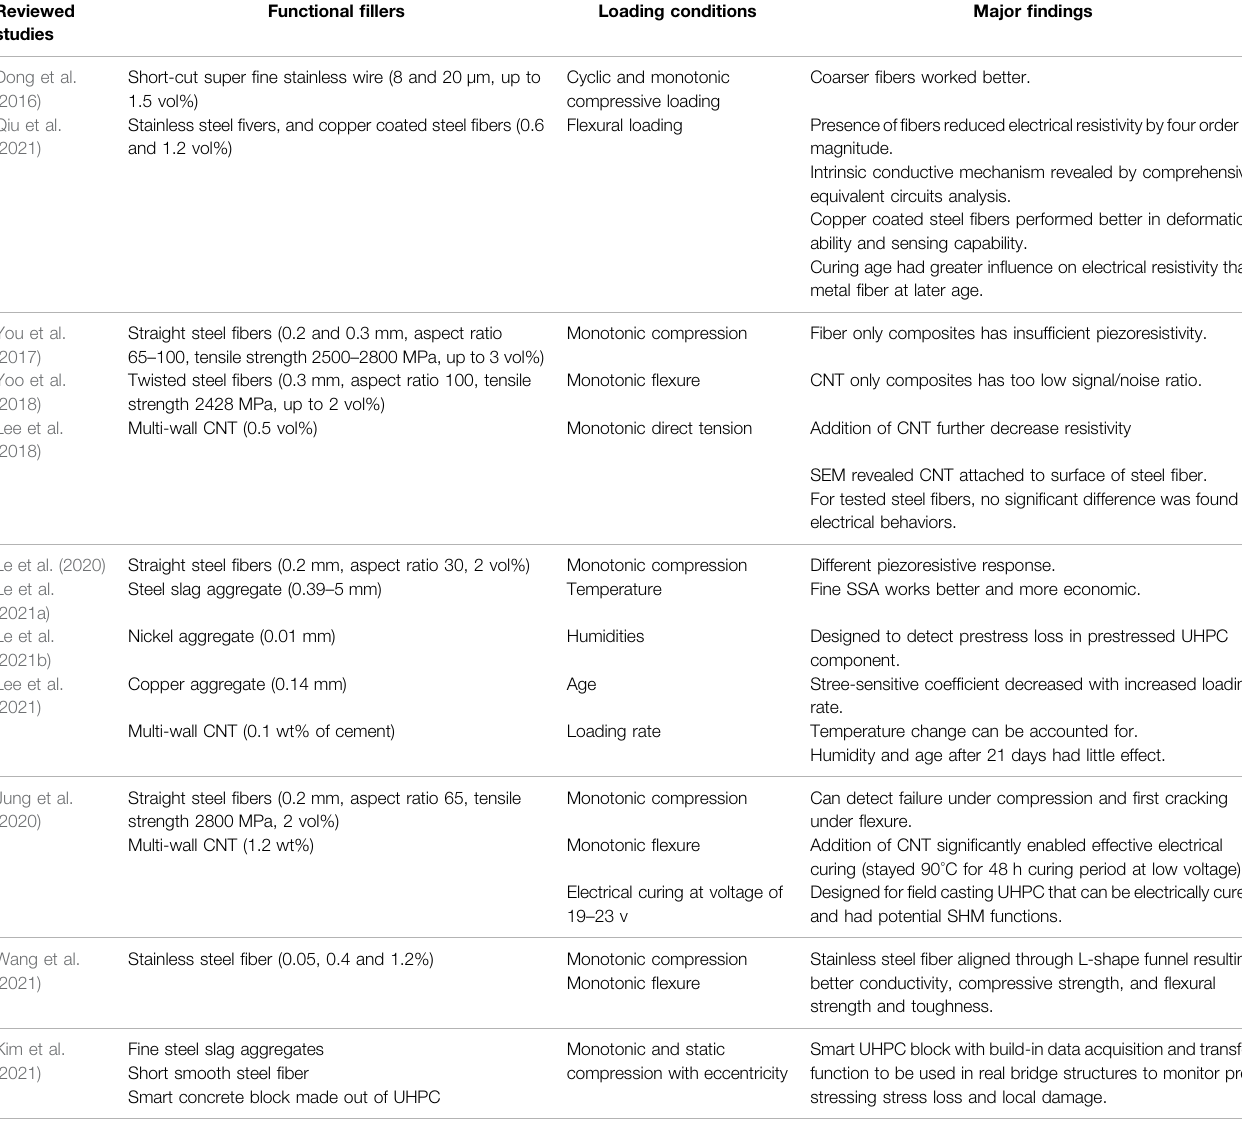
TABLE 1 | Summary of reviewed